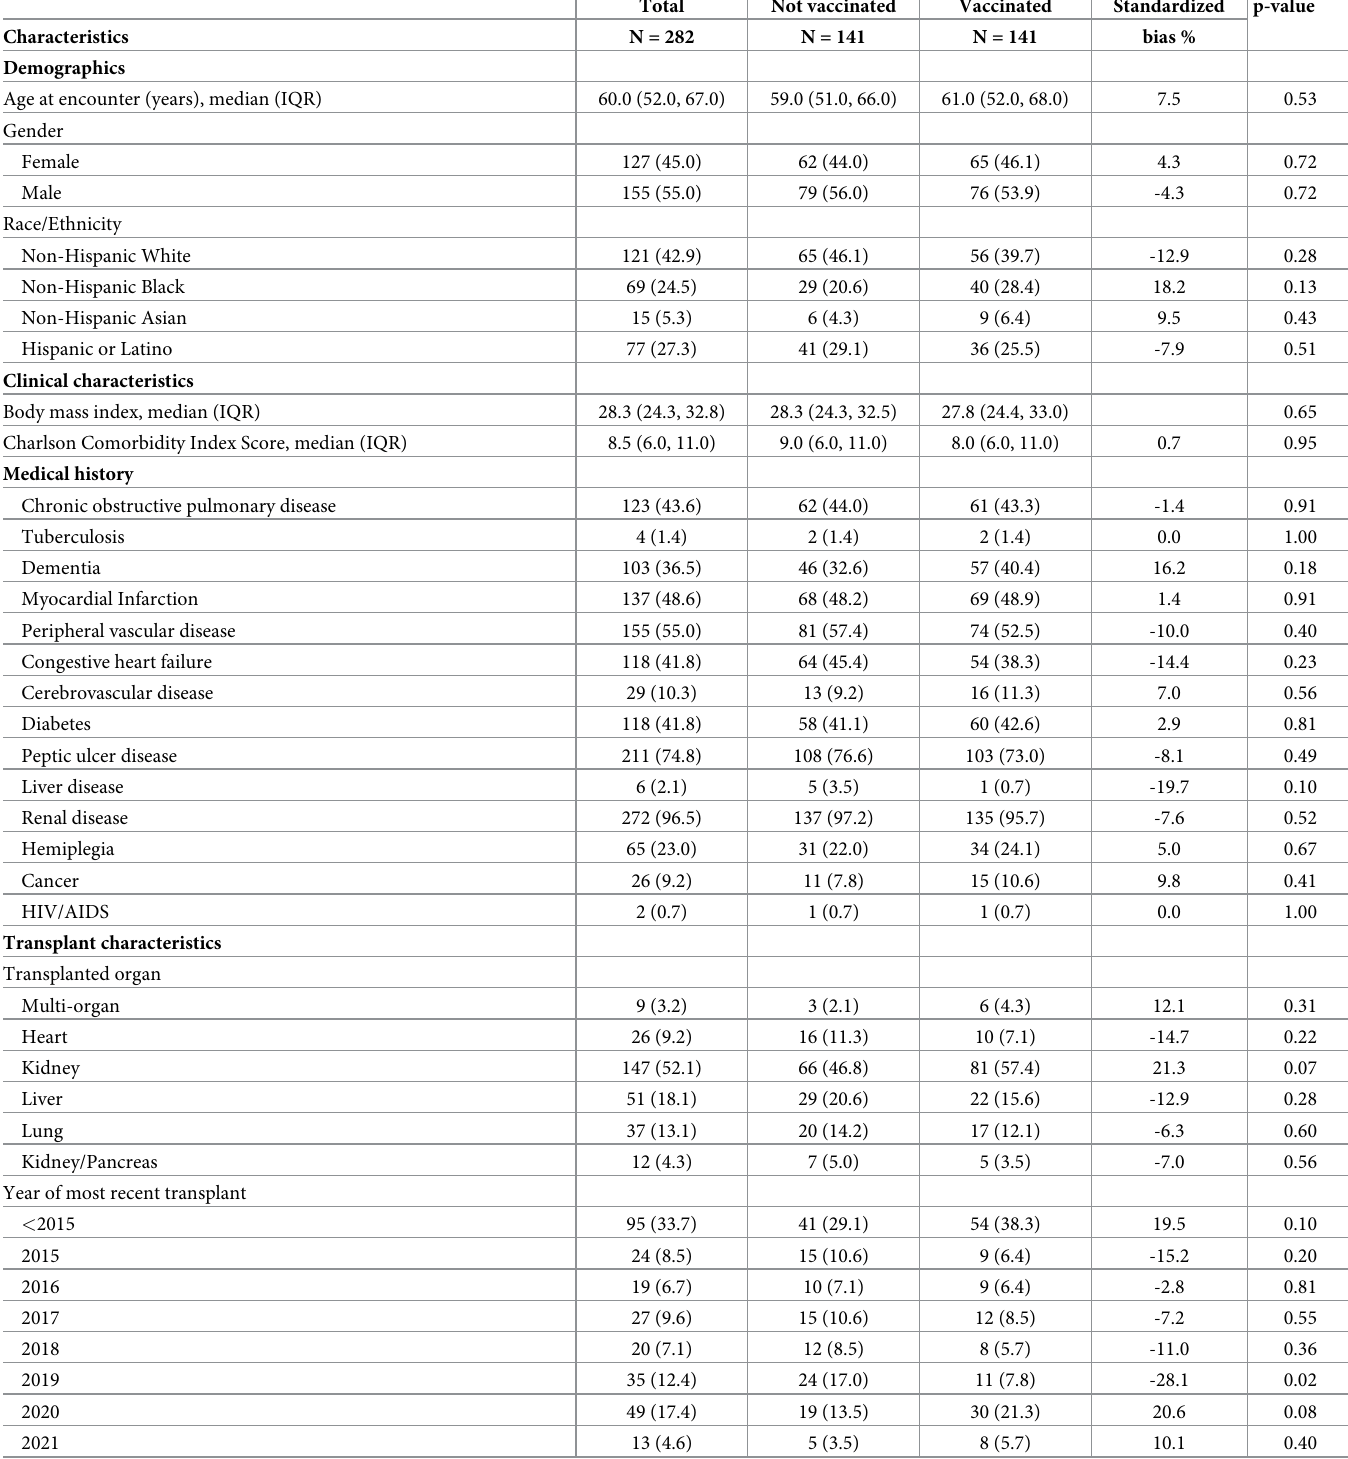
Table 4. Demographics and clinical characteristics of solid organ transplant recipients diagnosed with COVID-19 by vaccination status, propensity score matched cohort. Total Not vaccinated Vaccinated